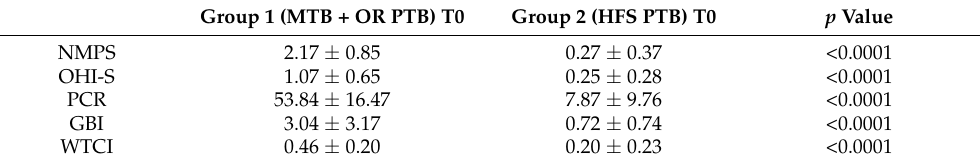
Table 2. Differences between the two groups in terms of oral hygiene indexes at the baseline